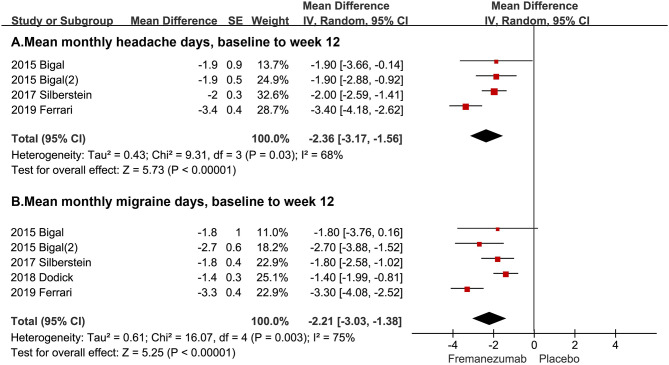
The pooled MD of primary outcomes. The red square indicates the estimated MD for each RCT. The size of red square indicates the estimated weight of each RCT, and the extending lines indicate the estimated 95% CI of MD for each RCT. The black diamond indicates the estimated MD (95% CI) for all patients together. (A) Mean monthly headache days, baseline to week 12. (B) Mean monthly migraine days, baseline to week 12. Weights are from random-effects analysis. CI, confidence interval; RCT, randomized controlled trial; MD, mean difference.